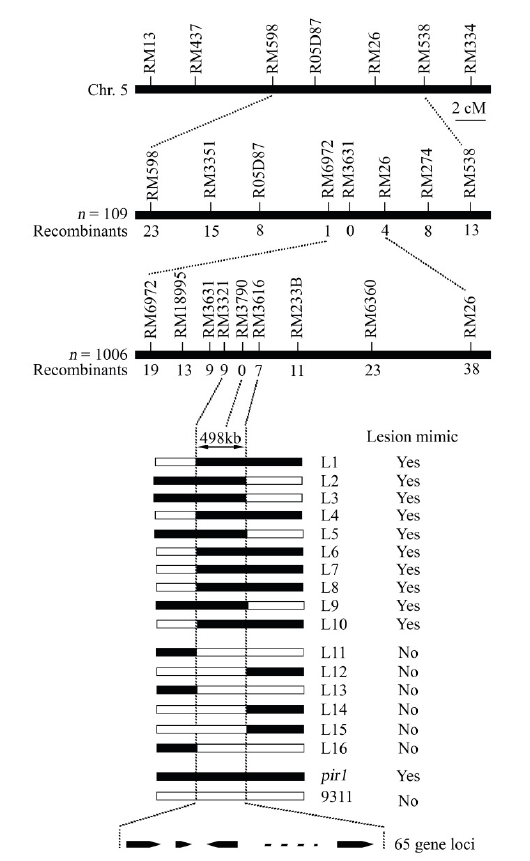
Figure 5. Mapping of the PIR1 gene. PIR1 locus was firstly mapped in the interval between markers RM6972 and RM26 on chromosome 5 and was further delimited to the interval between markers RM3321 and RM3616 by enlarging the mapping population from one of 109 individuals to 1006 individuals. The number of recombinants is indicated.